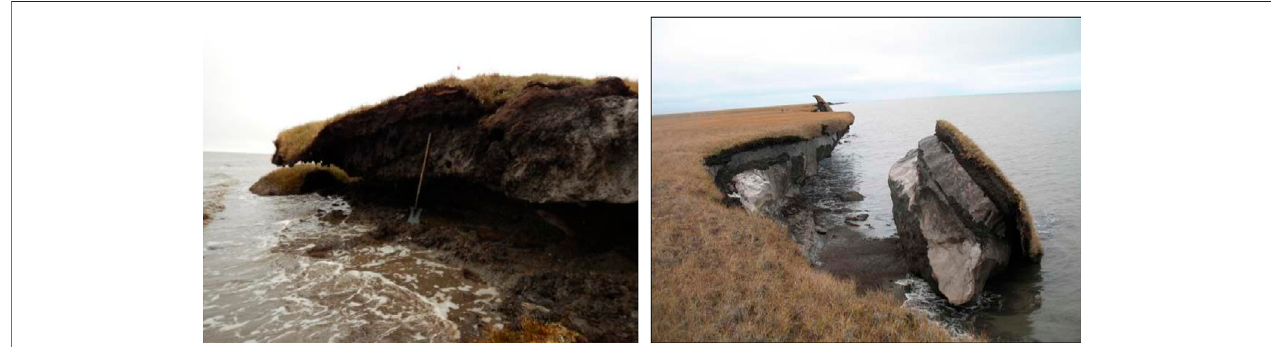
FIGURE3| Photosof (A) anerosionalnichefromElsonLagoonAlaskaand (B) afallenblockbyDrewPoint,Alaska(imagecourtesyofChristopherArpoftheAlaska Science Center, U.S. Geological Survey).